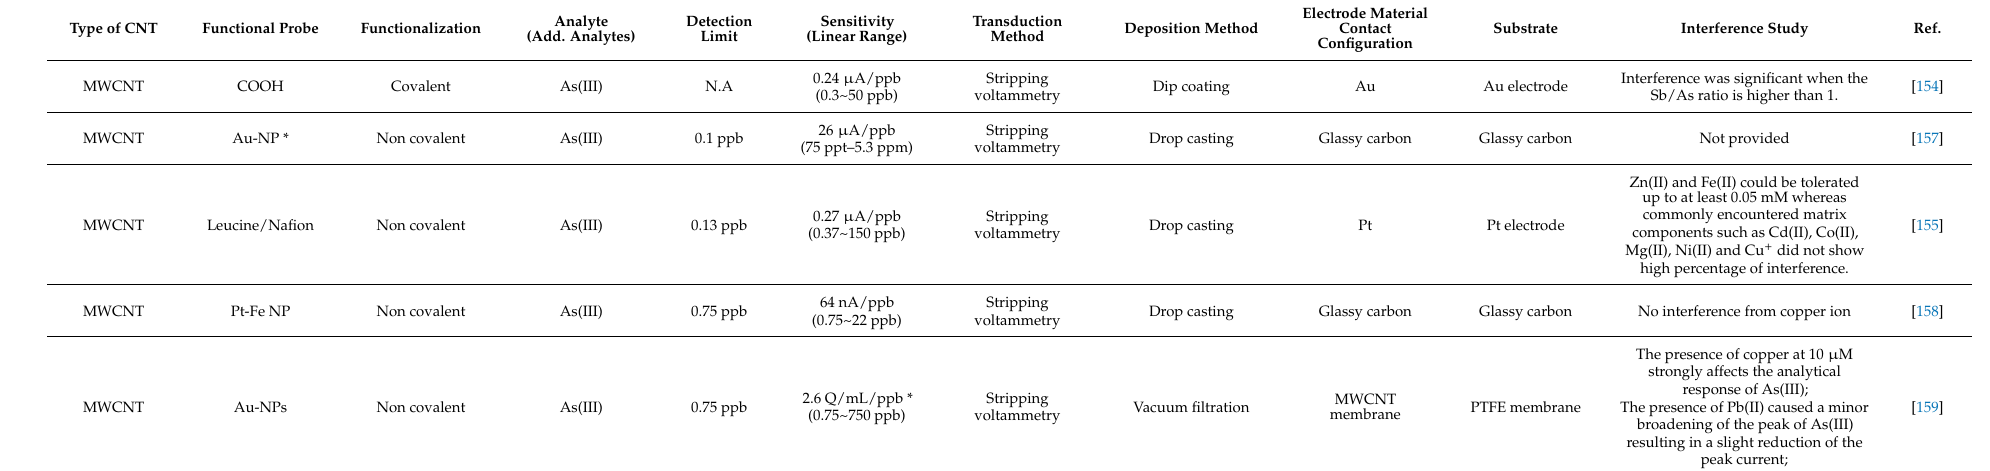
Table 7. CNT-based sensors for detecting As(III) ions in water, sorted by detection